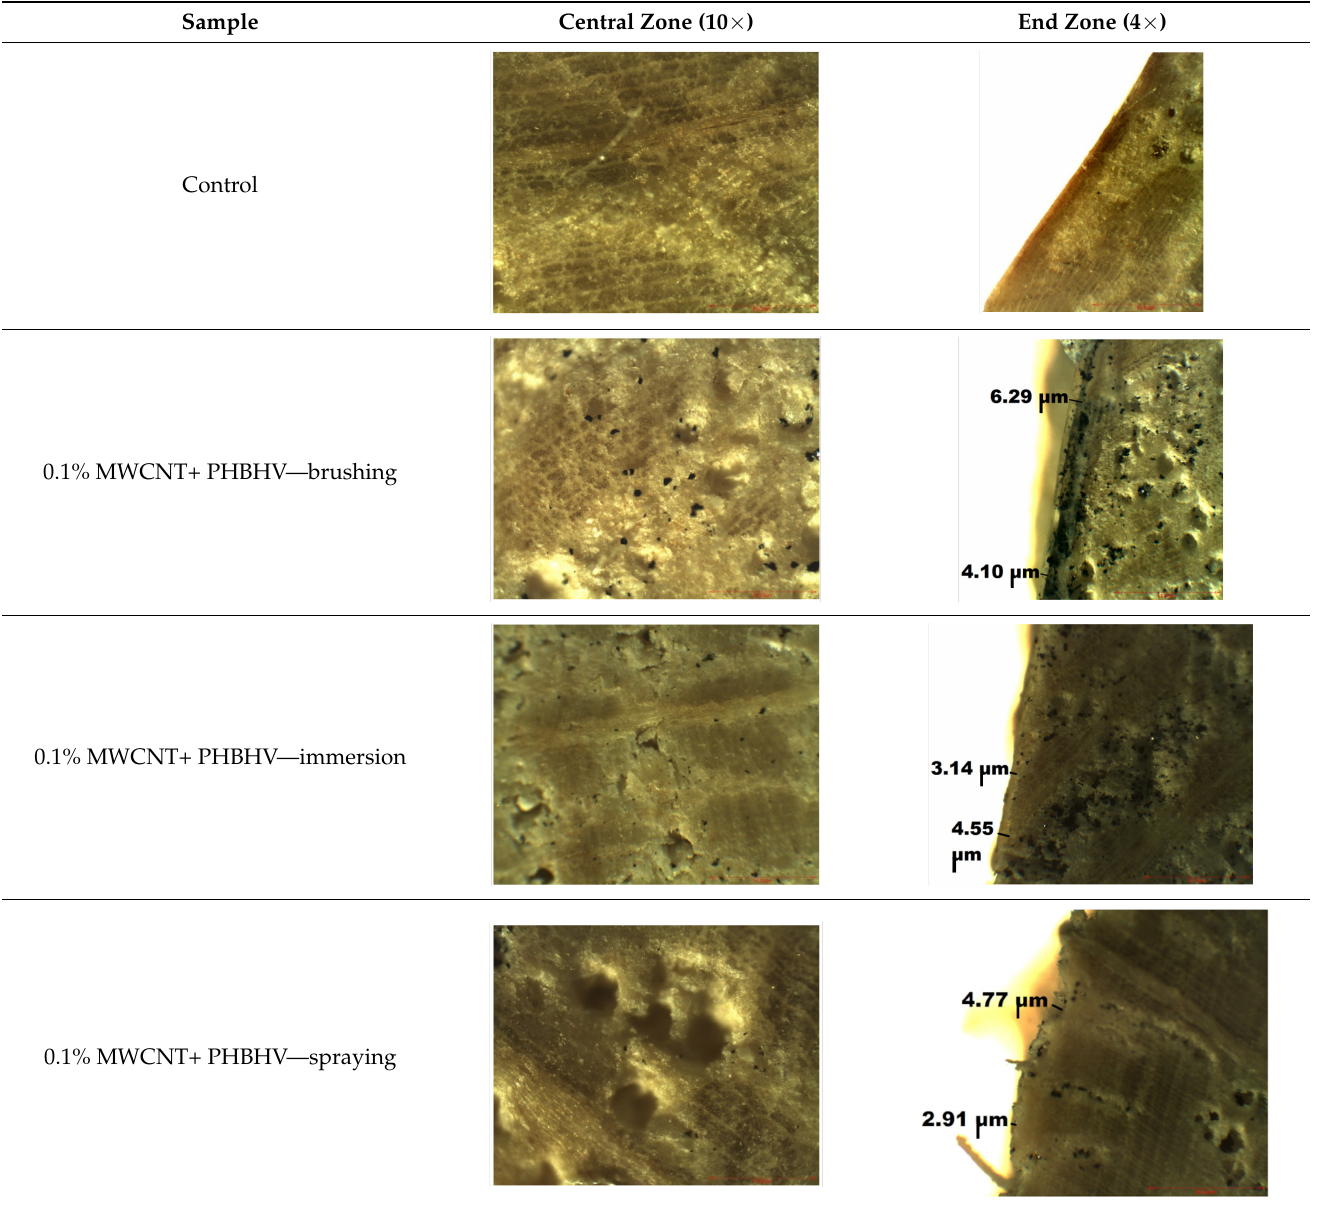
Table 1. Thickness of the untreated and treated wood pieces by brushing, immersion and spraying obtained by optical microscopy.